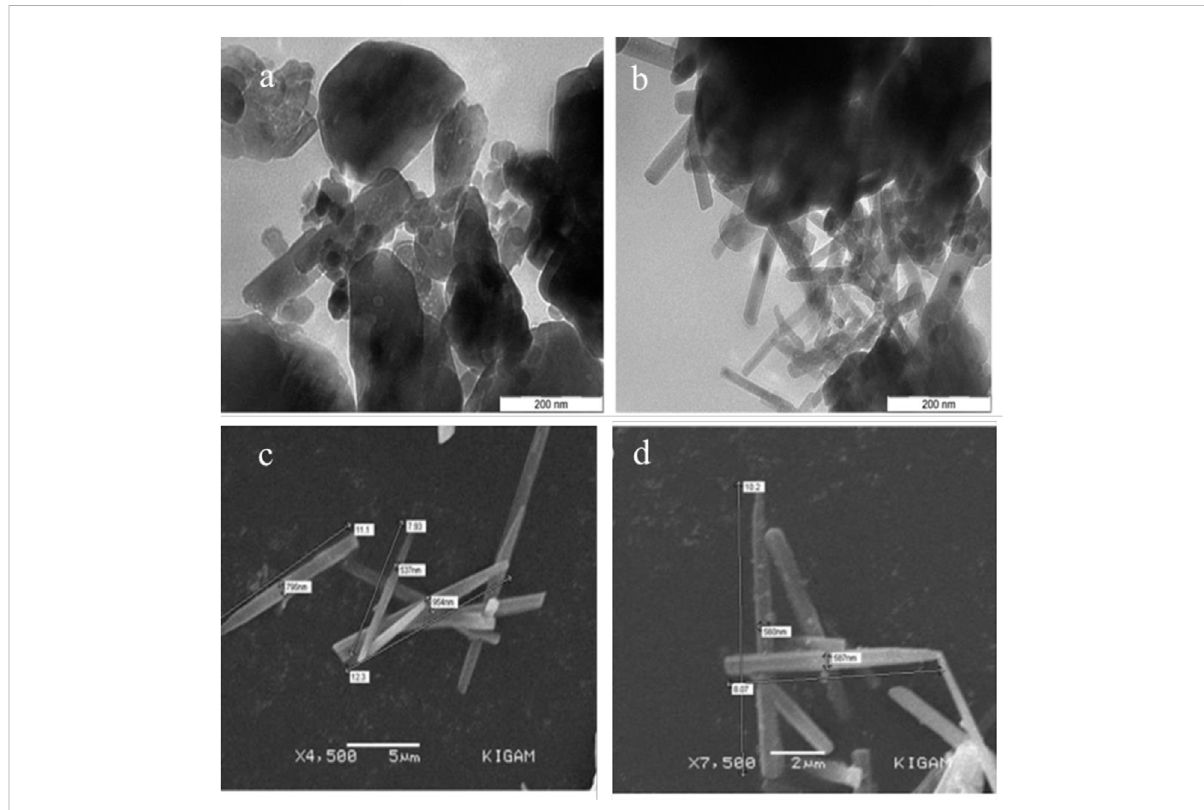
FIGURE 7 TEM microimages of aragonite crystals from cockle shell powders before (A) and after (B) the powder treatment. Reproduced with permission from Islam et al. (2013). SEM microimages of (C) aragonite crystals obtained from chicken eggshells and (D) aragonite crystals obtained from mixed bivalve seashells. Reproduced from Habte et al. (2020) “ Synthesis, characterization and mechanism study of green aragonite crystals from waste biomaterials as calcium supplement ” https://www.mdpi.com/2071-1050/12/12/5062 licensed under CC BY 4.0.